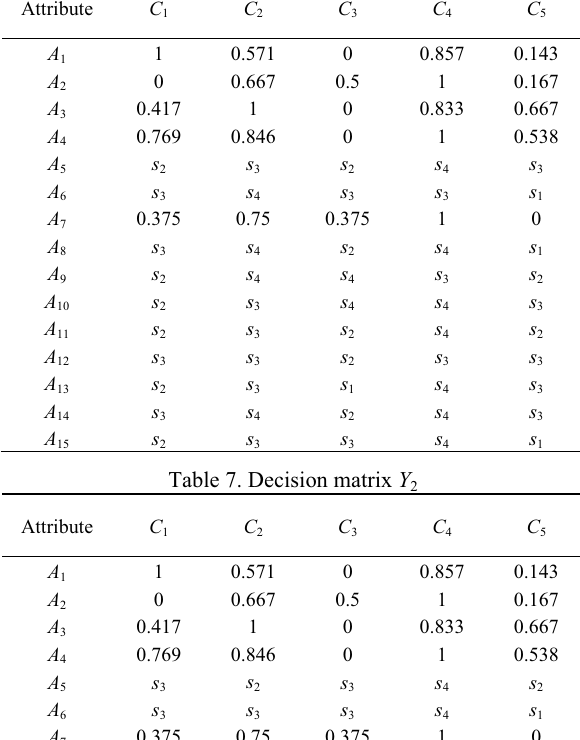
Table 6. Decision matrix Y 1